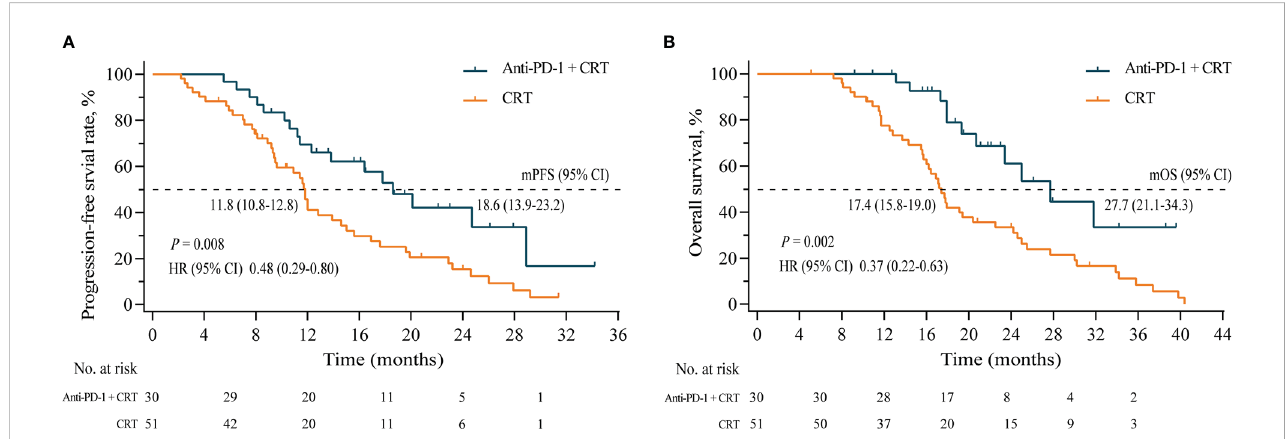
FIGURE 3 (A) , Progression-free survival of the Anti-PD-1+CRT group (n = 31) and the CRT group (n =51); (B) , Overall survival of two groups. Anti-PD-1, anti- programmed cell death protein 1; CRT, chemoradiotherapy; mPFS, median progression-free survival; mOS, median overall survival; HR, hazard ratio; CI, con fi dence